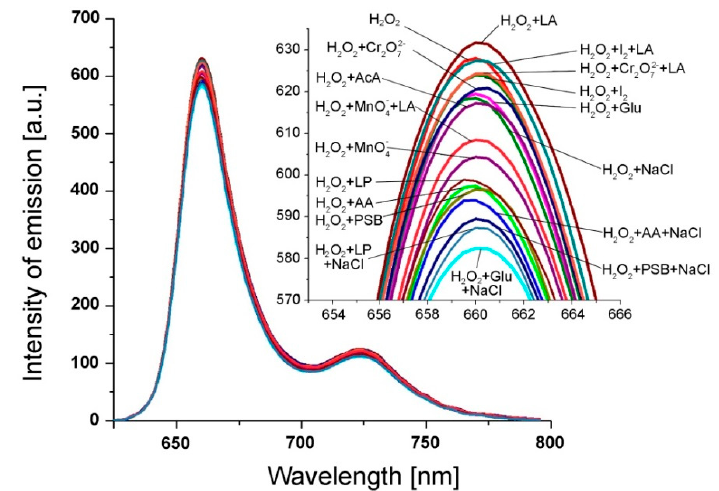
Figure 6. Fluorescence spectra of Pt(II)-TAPP containing H 2 O 2 (c = 2 × 10 − 6 M) in DMSO and in the presence of di ff erent interference analytes: LA; I 2 + LA; Cr 2 O 7 2 − + LA; I 2 ; Cr 2 O 7 2 − ; Glu; NaCl; AcA; MnO 4 − + LA; MnO 4 − ; LP; AA; PSB; AA + NaCl; PSB + NaCl; LP + NaCl; Glu + NaCl. The concentration of each potential interfering analyte was 2 × 10 − 4 M.